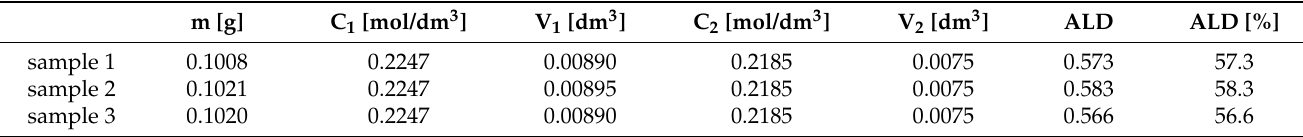
Table 1. Content of aldehyde group determination